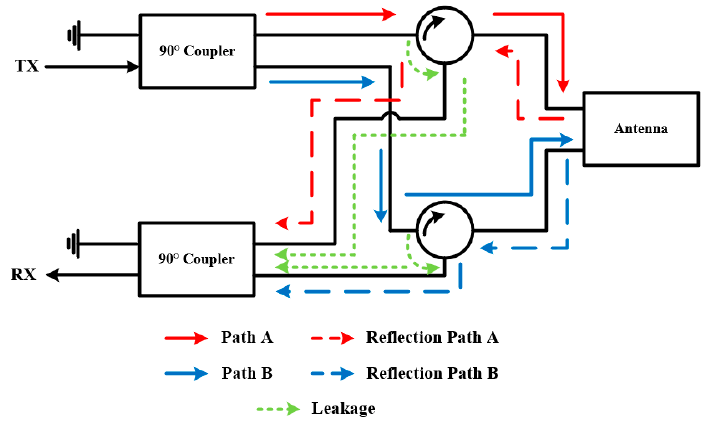
Figure 12. Typical isolation feed network employing circulators and couplers.